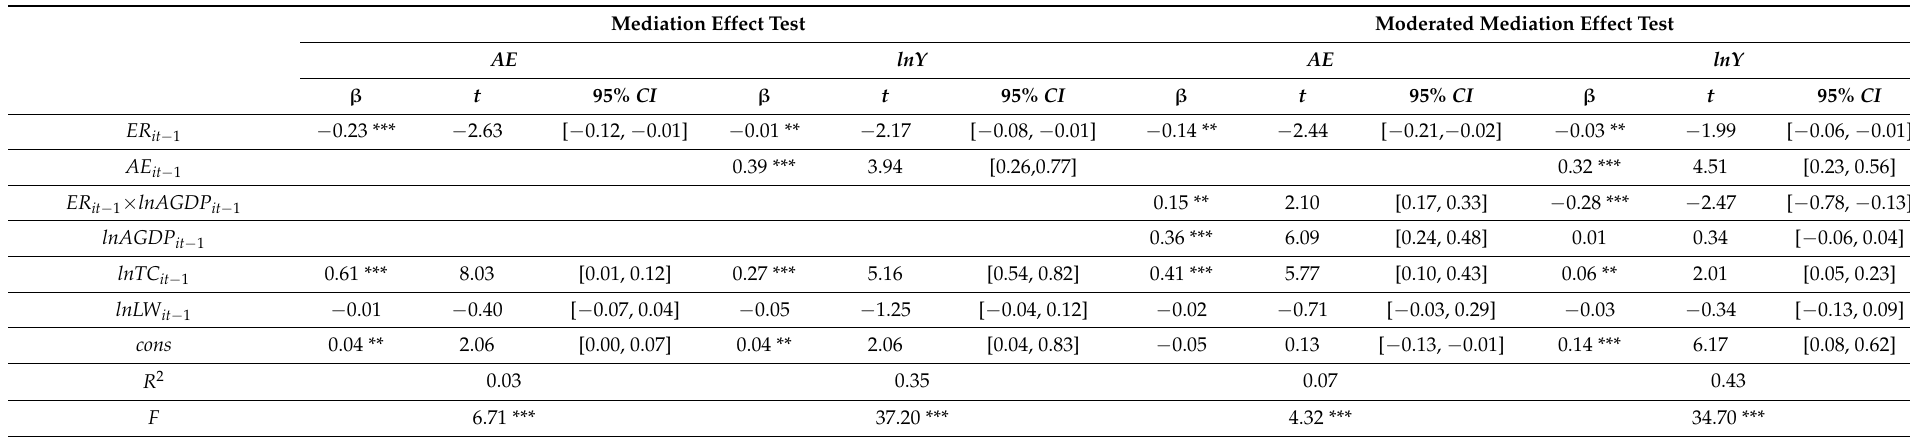
Table 4. Regression results of the moderated mediation model (Bootstrap = 5000)